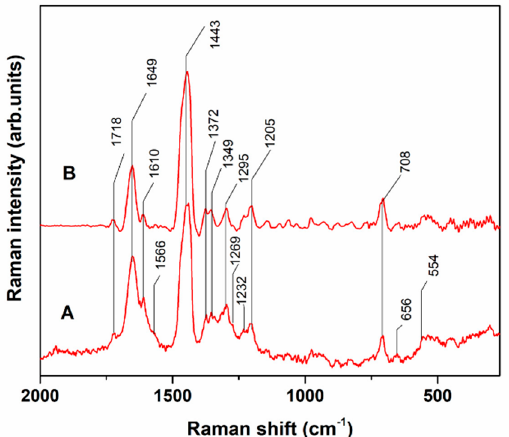
Figure 2. Examples of Raman spectra of a fossil resin (from Sakhalin, Russia) collected with (A) laboratory and (B) handheld equipment (figure from [4]; see reference for details).